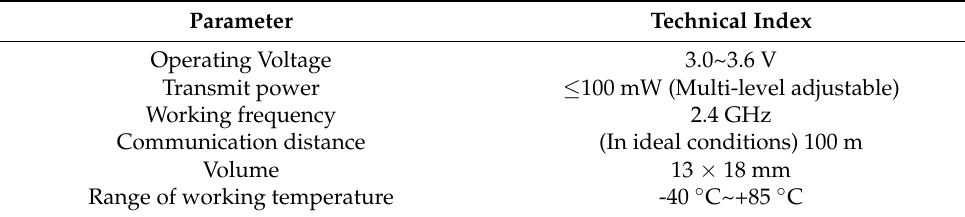
Table 4. E103-W01 Wi-Fi module performance description.